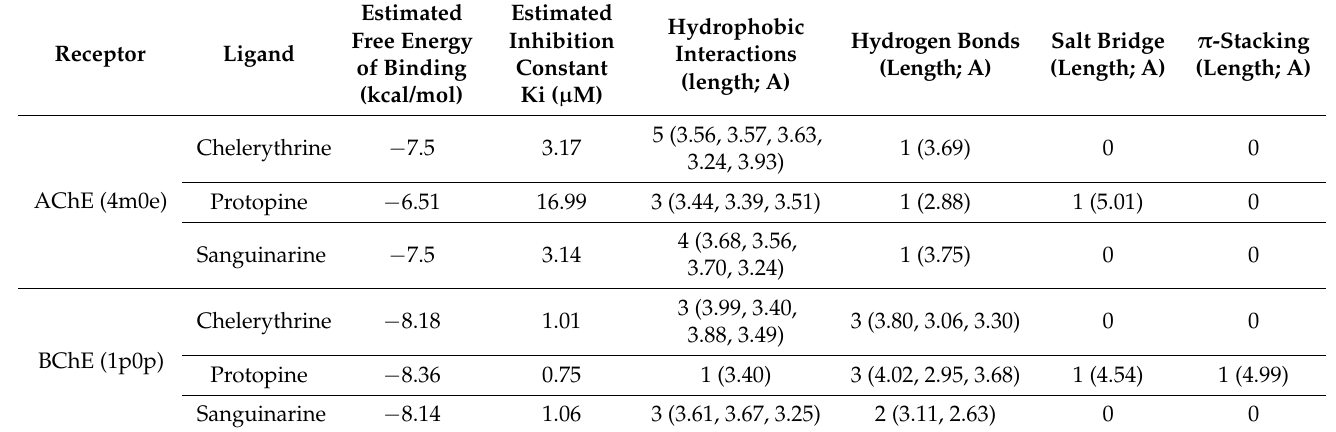
Table 8. Predicted binding sites for butyrylcholinesterase.